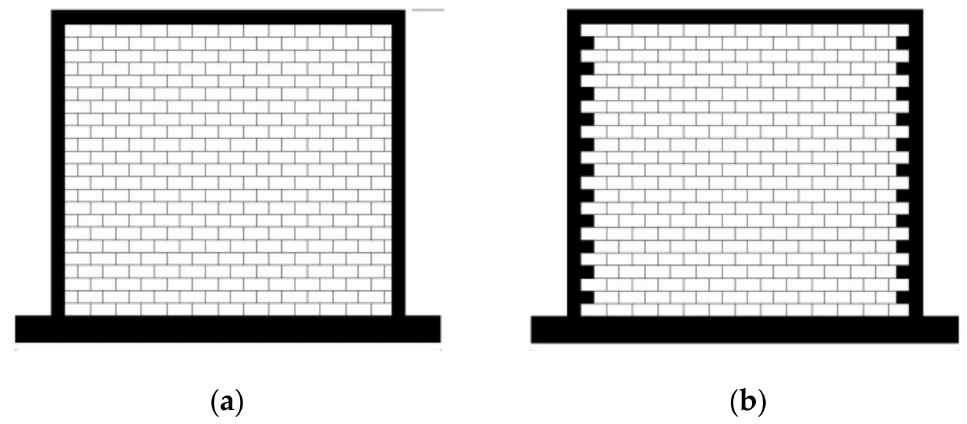
Figure 10. Schematic view of small-scaled ( a ) infilled, ( b ) confined, masonry